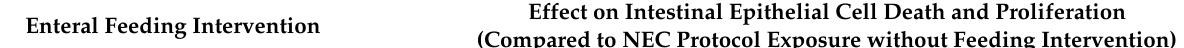
Table 10. Effect of enteral feeding interventions that decrease intestinal epithelial cell death and increase proliferation in experimental animal models of